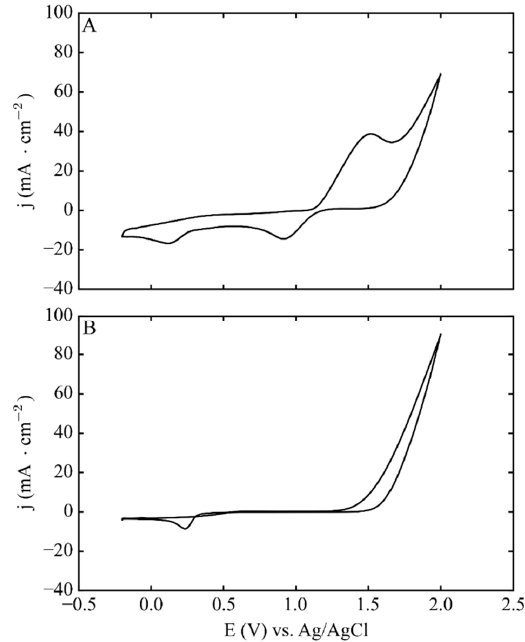
Figure 11. CVs of a 1.6 mm diameter Pt electrode in ( A ) 0.1 M HCl and in ( B ) 0.05 M H 2 SO 4 , ν = 0.5 V/s.